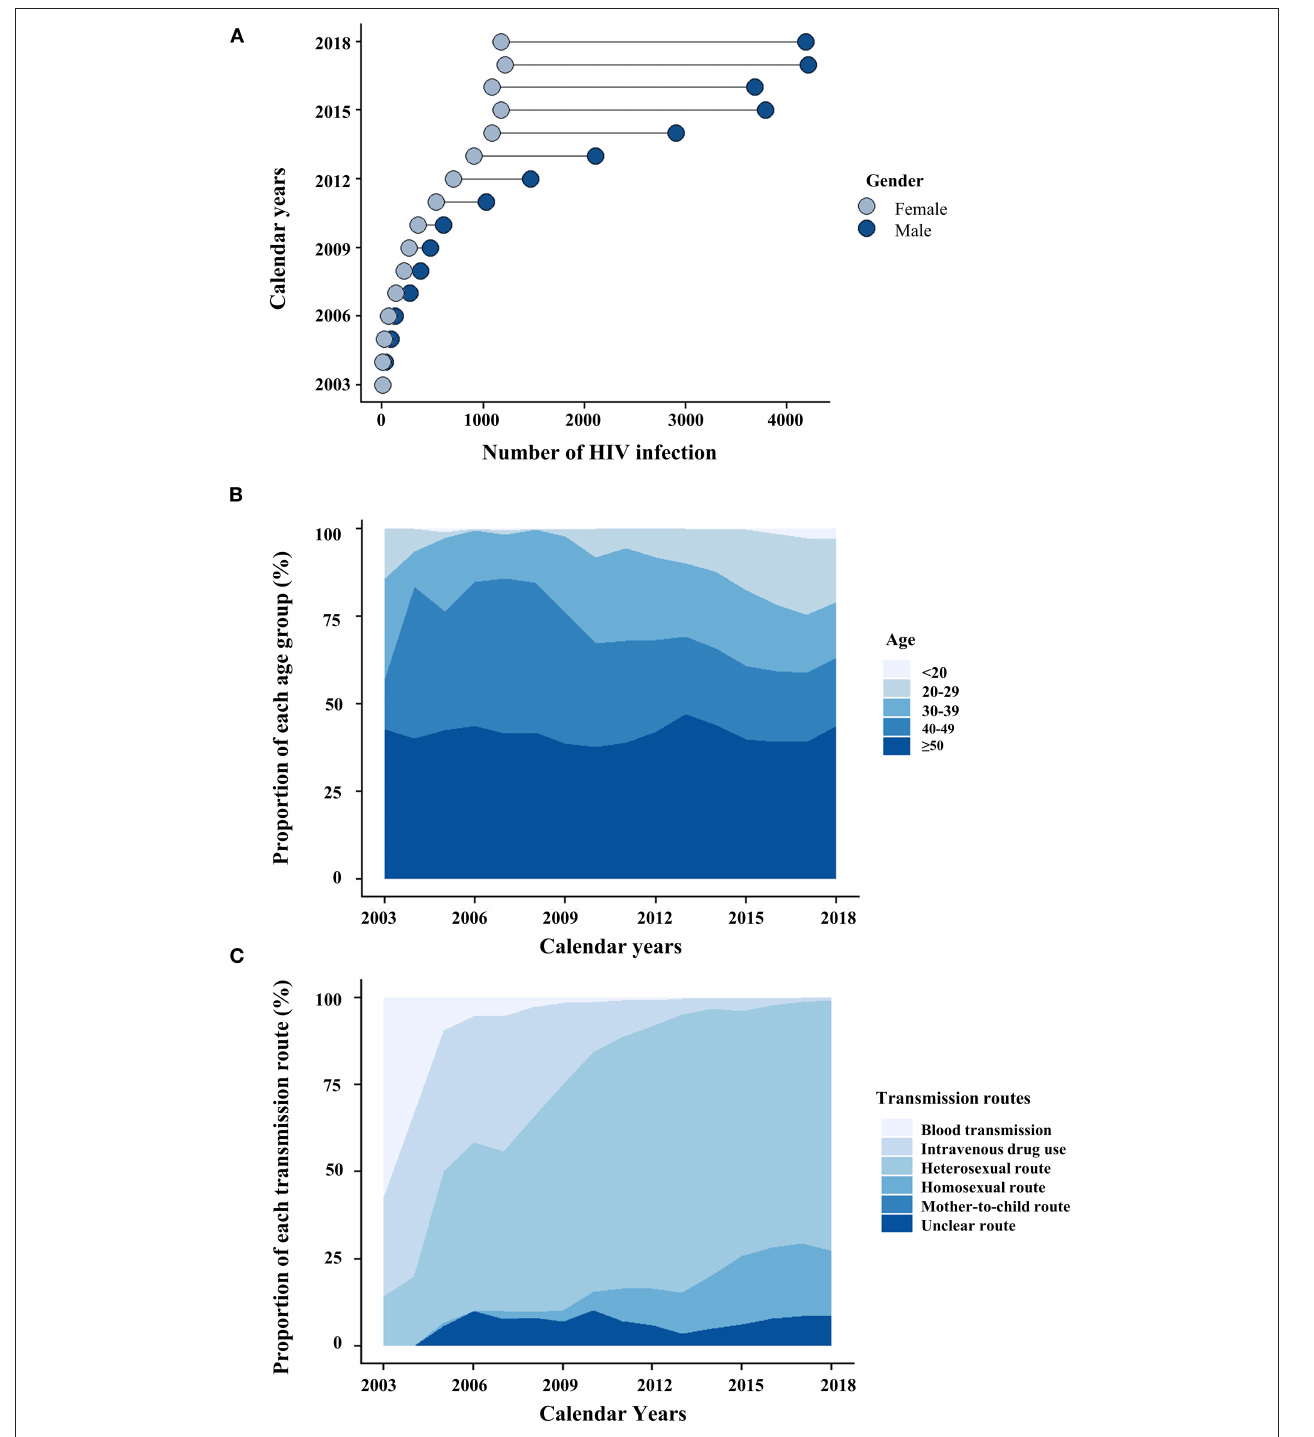
FIGURE 1 | The dynamics of HIV-infected patients are categorized by gender (A) , age (B) , and transmission routes (C) .